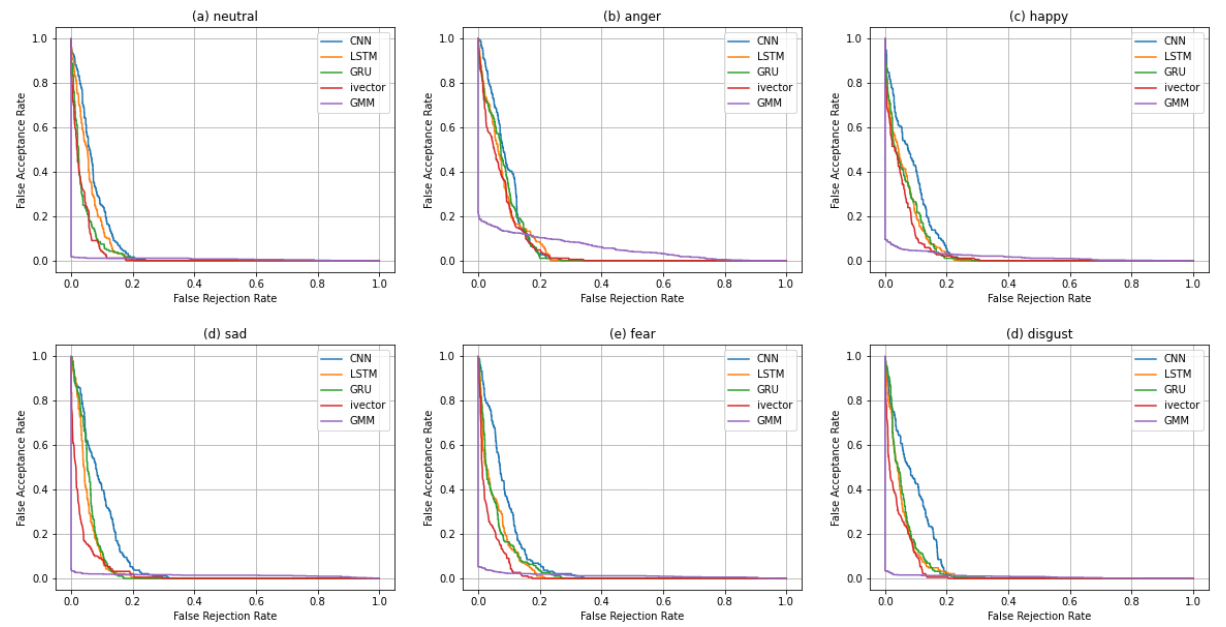
Figure 7. DET curves with each based on GMM, KNN, SVM, ANN, CNN, LSTM, and GRU models for the different emotional states using the Emirati database.